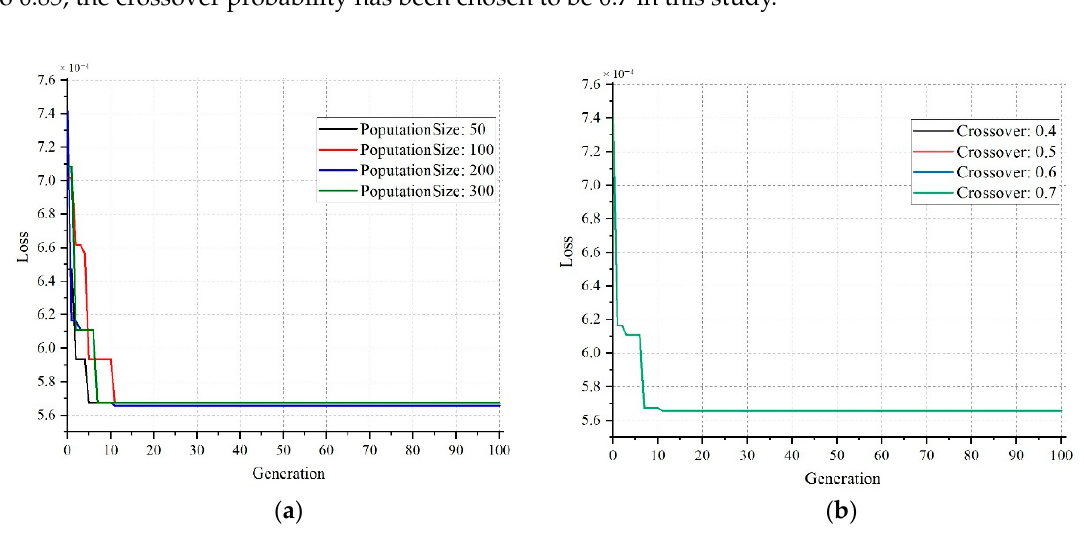
Figure 10. Effect of varying the mutation probability for estimating loss ( a ) and generations for fitness value ( b ).